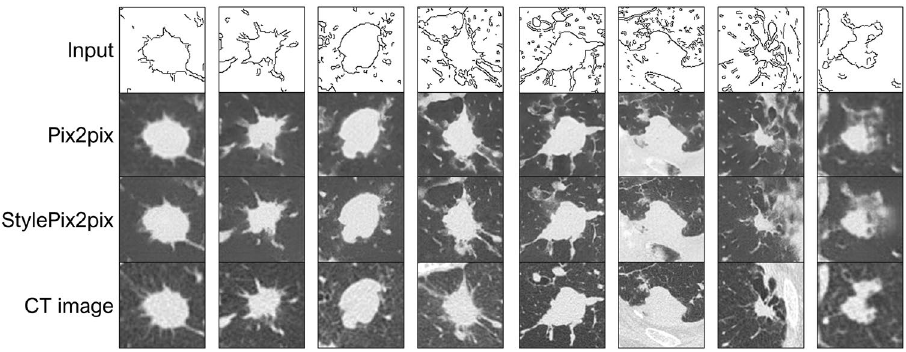
Figure 5. Examples of the image generation result using edges.